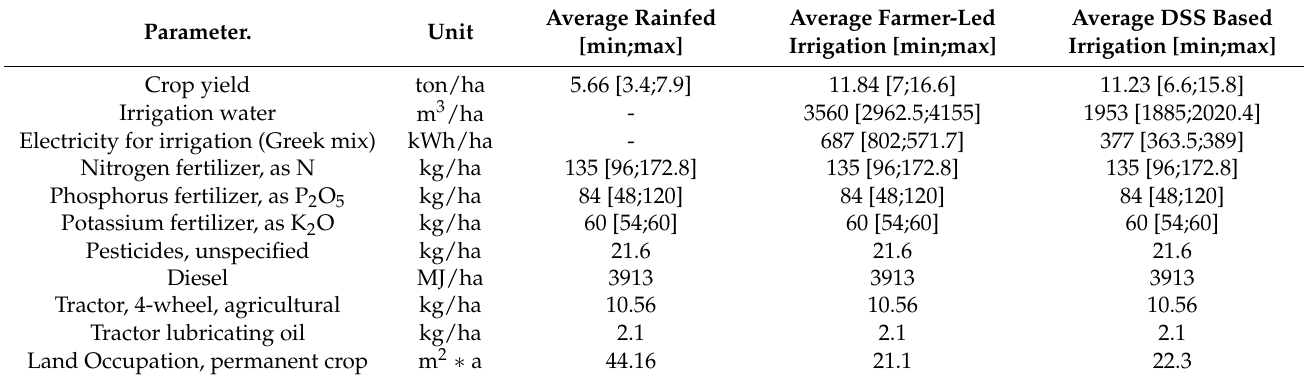
Table 2. Inventory data for LCA performance of olive growing systems in the plain of Arta.